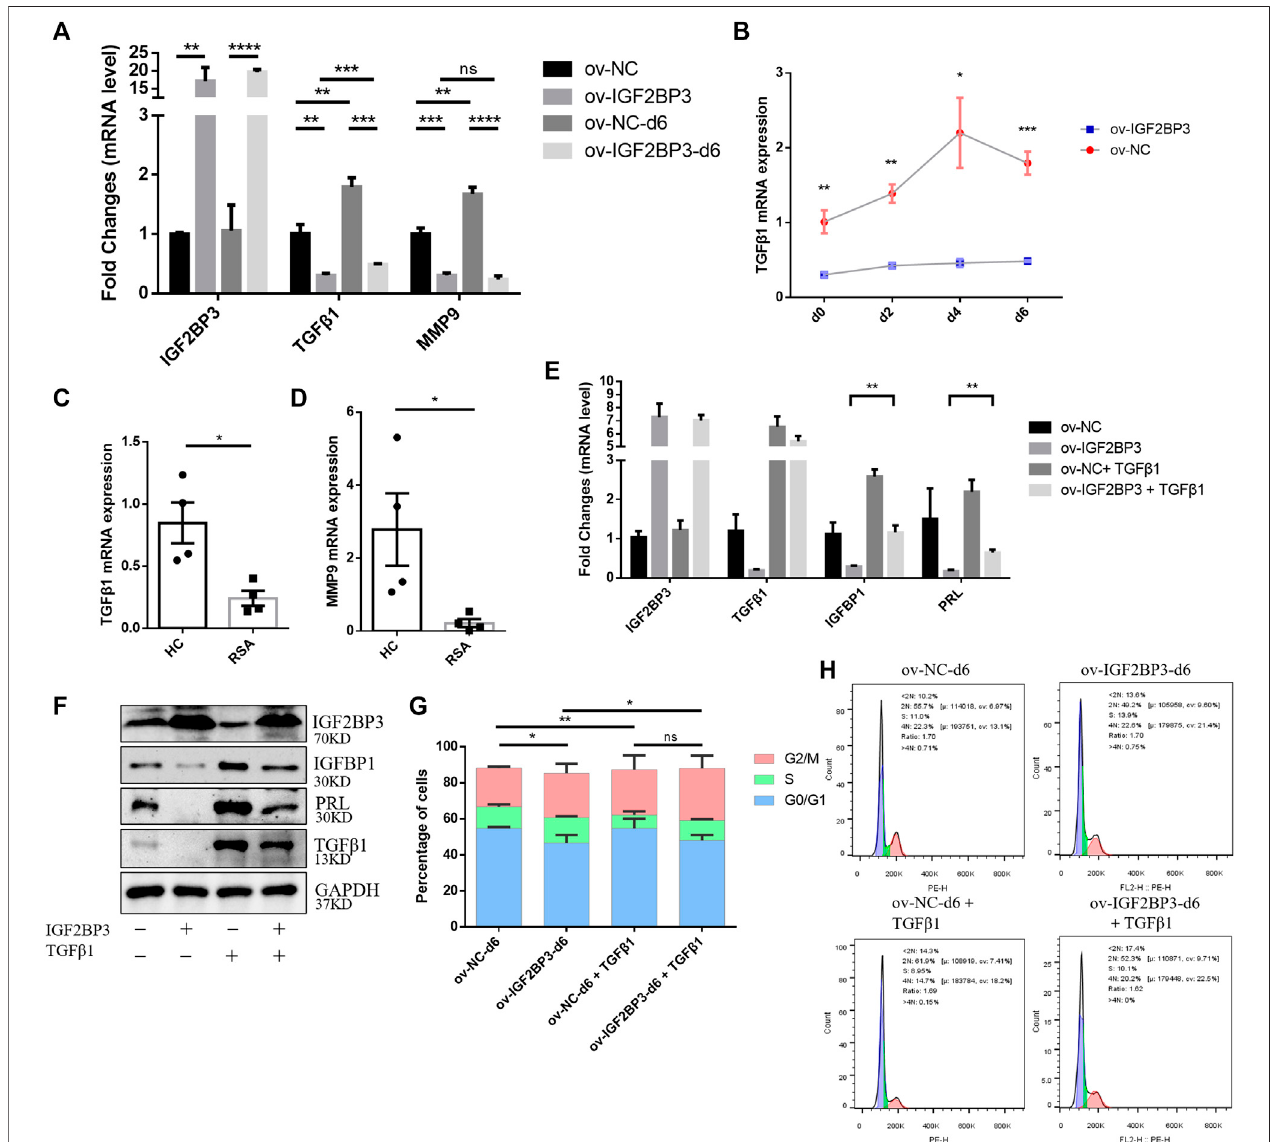
FIGURE 3 | IGF2BP3 and TGF- β 1 in decidualization (A) mRNA expression of decidualization-related transcriptional factors including TGF- β 1 and MMP9 decreasedinHESCs upontheinduction ofdecidualization invitro afterinfectedwithov-IGF2BP3 (B) IGF2BP3overexpressioninhibitsTGF- β 1time-dependent increase during the decidualization of hESCs, (C,D) TGF- β 1 and MMP9 mRNA levels were reduced in decidua of RSA compared with HCs patients ( n = 4 per group), (E,F) addition of exogenous TGF signi fi cantly increased the decidualization of hESCs and restored the RNA and protein expression levels of decidualization marker molecules (IGFBP1 and PRL) in the IGF2BP3 overexpression group, and (G,H) cell cycle distribution of ov-IGF2BP3 or ov-NC-infected hESC during decidualization in vitro . Addition of TGF- β 1 to ov-IGF2BP3 or ov-NC-infected hESCs, comparison of cell cycle distribution during day 6 in vitro decidualization. TGF can reverse the S-phase accumulation caused by IGF2BP3 overexpression. Data represent mean ± SEM from three separate experiments, and are shown as the mean ± SEM. * p < 0.05, ** p < 0.01, *** p < 0.001, and **** p < 0.0001 vs. control.